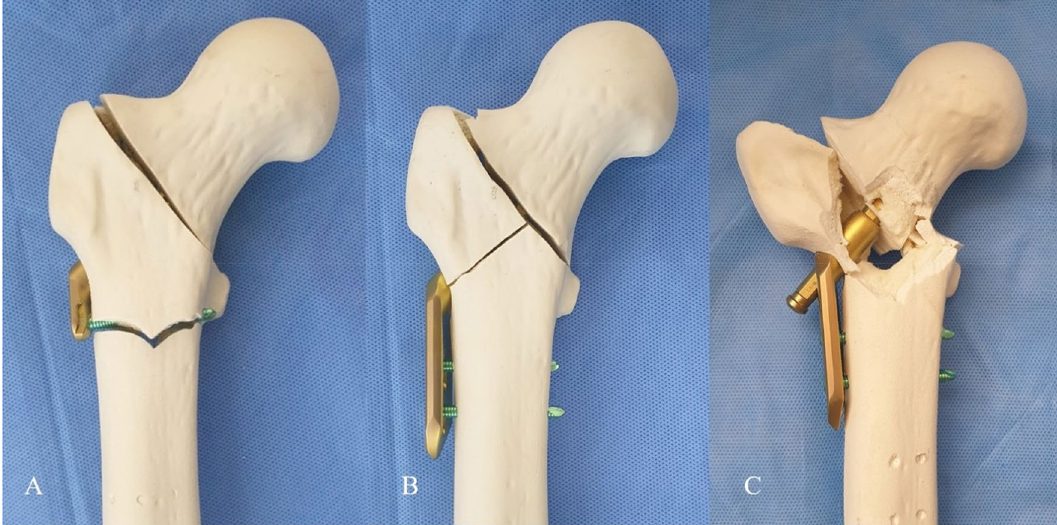
Figure 1. Specimens showing different locations of construct failure including ( a ) peri-implant fracture distal to screw hole in FNS group, ( b ) lateral wall fracture around lag screw in DHS group, and ( c ) displaced lateral wall fracture with varus collapse and lag screw pull-out in DHS